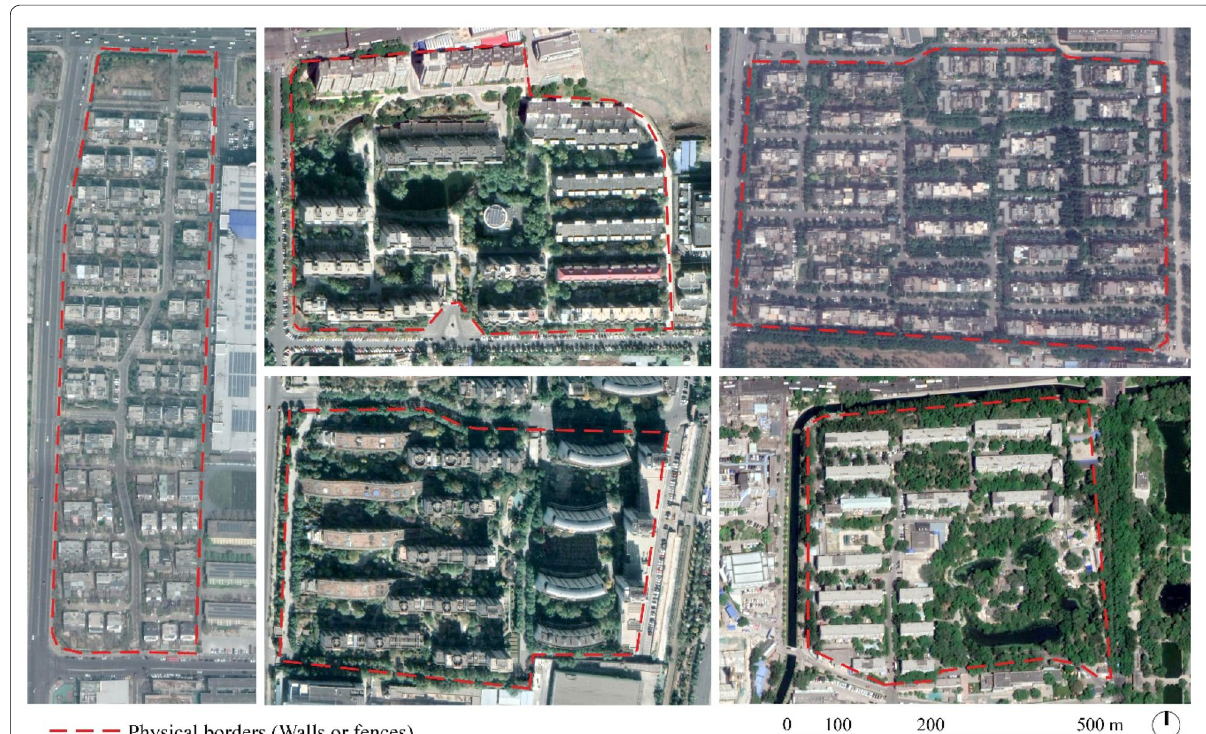
Fig. 7 Plans of different gated communities in Haidian District, Beijing. Most of them are large-scale gated superblocks with their own property management systems and structure (Illustrated by the author based on Baidu maps,